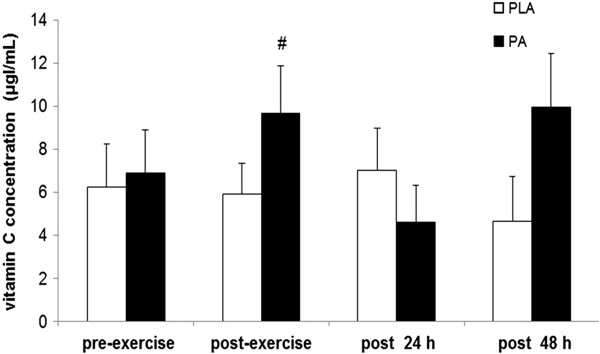
Vitamin C concentration before exercise (pre-exercise), immediately after (post-exercise), and 24 h (post 24 h) and 48 h (post 48 h) after high-intensity exercise. Values are presented as mean ± SE (n = 12). PLA, placebo. #Significantly different from the PLA group at the same time point (p < 0.05).